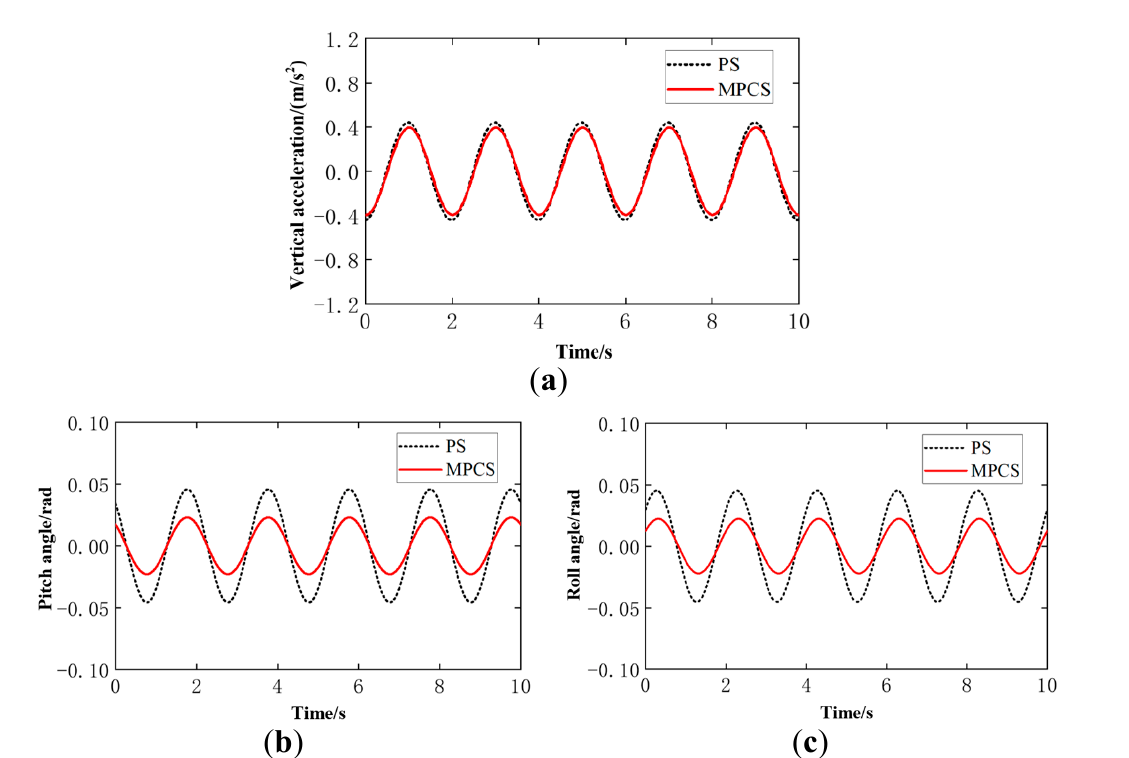
Figure 10. Simulation results of attitude control on a sinusoidal road: ( a ) Heaving acceleration of car body; ( b ) Pitching angle of car body; ( c ) Rolling angle of car body.